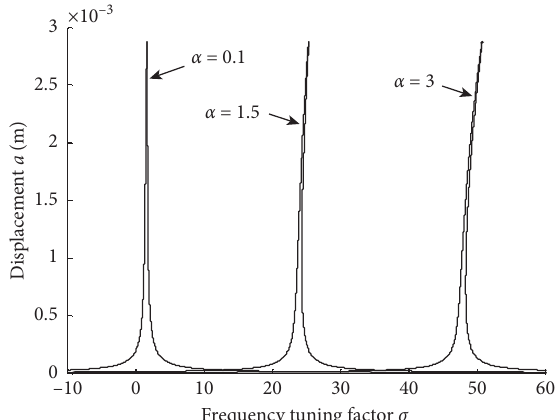
Figure 6: Influence of nonlinear spring force coefficient on amplitude frequency characteristic curve.